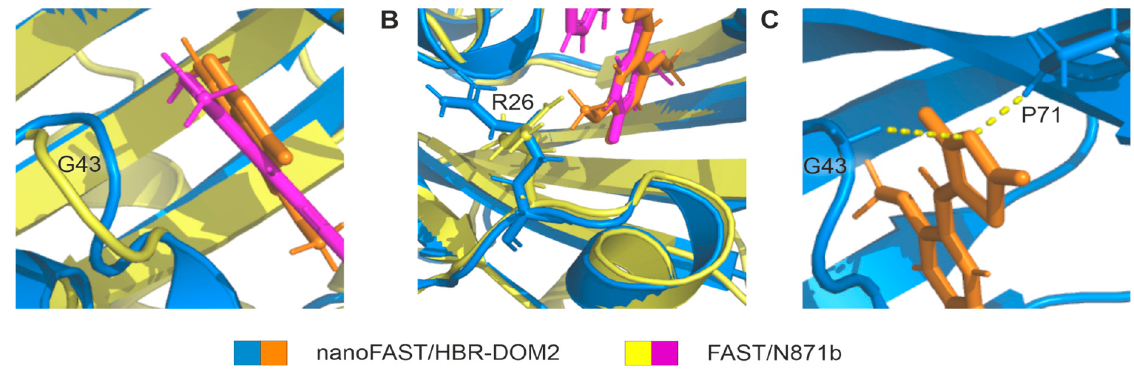
Figure 3. Comparison of nanoFAST/HBR-DOM2 (shown in blue and orange) and FAST/N871b (shown in yellow and magenta). ( A,B )—Superimposed spatial structures of nanoFAST/HBR-DOM2 and FAST/N871b are displayed with the zoom at the regions with the most significant differences, R26 and G43. ( C )—Non-canonical CH–N contacts between the nitrogen of rhodanine and protons of G43 and P71. Key amino acid residues are indicated by letter and